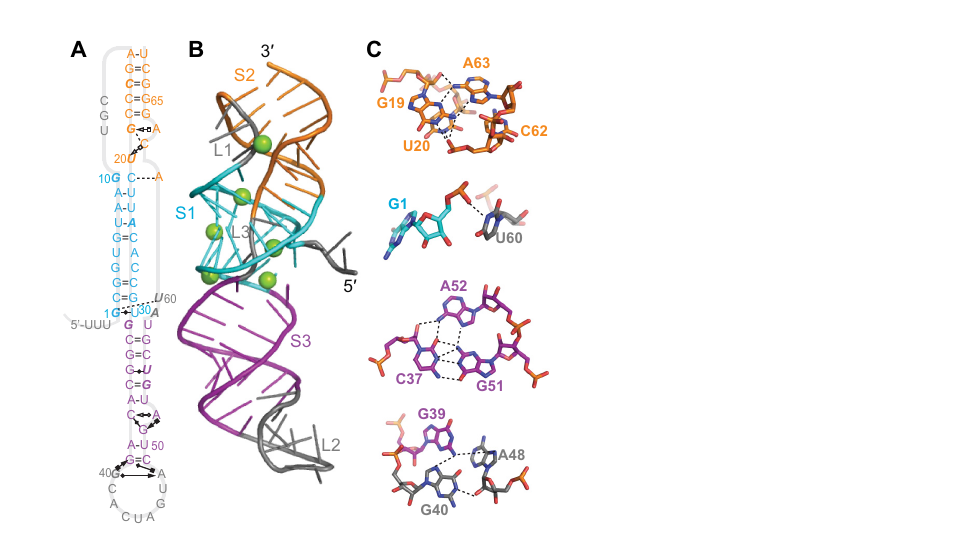
Fig 5. Representative structures from MD simulations of models with L3 threading. (A–C) Structure from simulation of Fig 2H with Mg 2+ . (A) Secondary structure with tertiary contacts, notated as in Fig 3. Bases shown in italic are protected against nuclease digestion in SARS-CoV-1. (B) Representative 3D structure of most populated cluster. Mg 2+ ions shown in green. (C) Close-up view of key tertiary contacts.